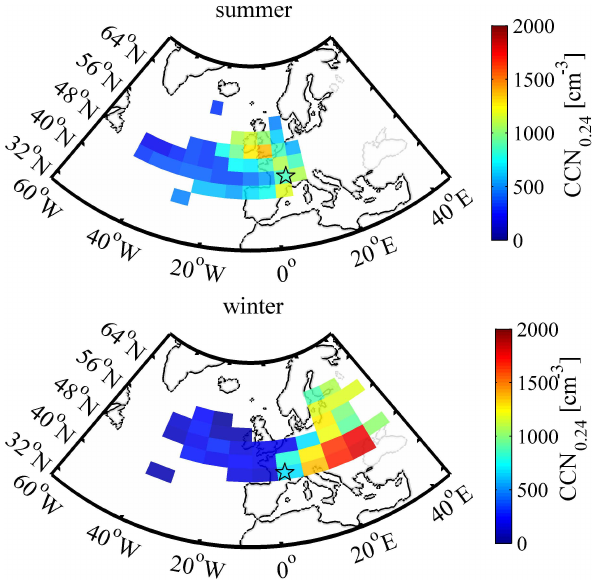
Fig. 6. CCN 0 . 24 concentrations with the air mass origin during sum- mer (up) and winter (down). The star marks the location of the mea- surement site. For details of the calculations, see Sect. 3.3: aerosol CCN properties by air